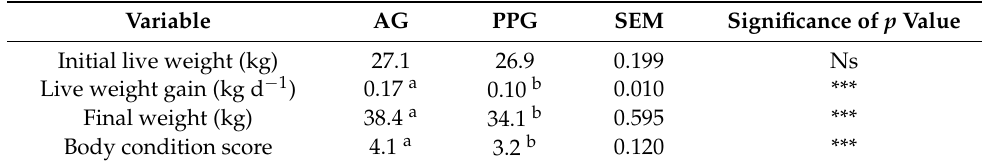
Table 3. Effects of pasture type on lamb performance. Variable AG PPG SEM Significance of p Value Initial live weight (kg) 27.1 26.9 0.199 Ns Live weight gain (kg d − 1 ) 0.17 a 0.10 b 0.010 *** Final weight (kg) 38.4 a 34.1 b 0.595 *** Body condition score 4.1 a 3.2 b 0.120